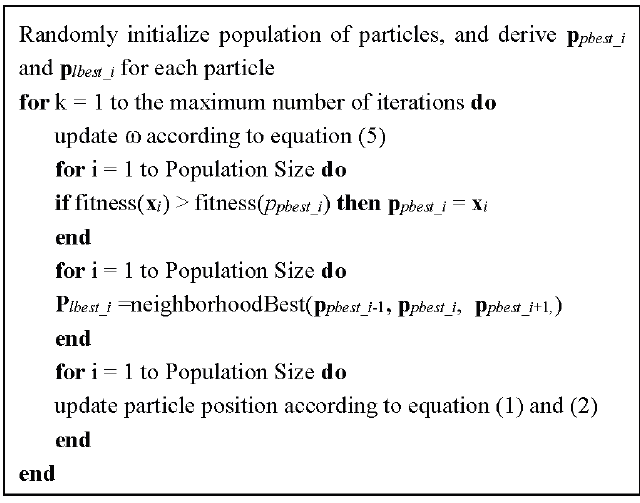
Figure 3. Pseudocode of a PSO using a ring topology.